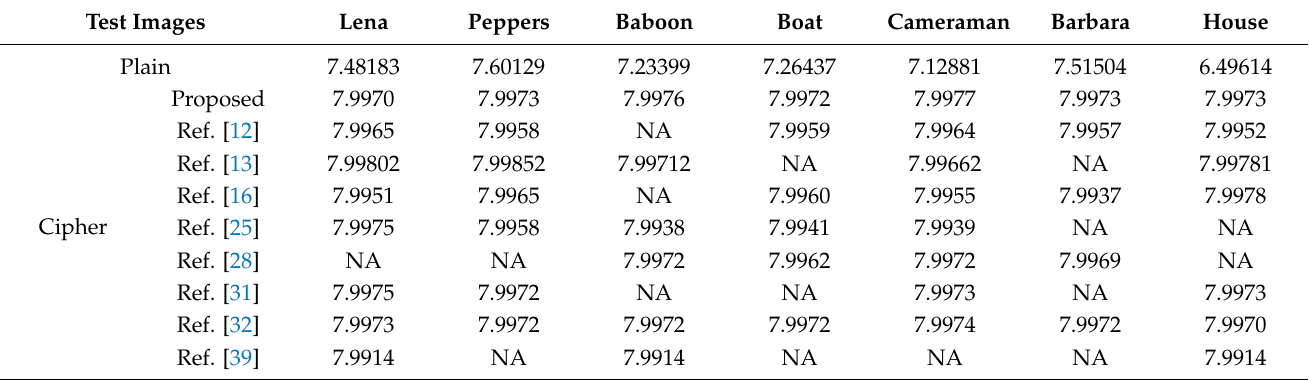
Table 3. Entropy Analysis of Proposed versus Existing methods.